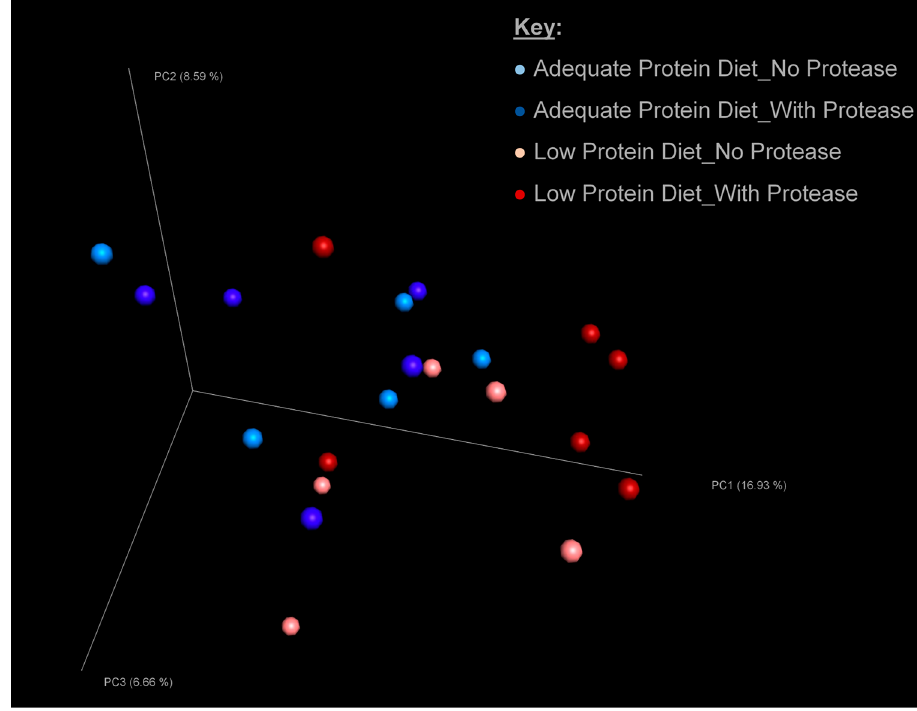
Figure 1. Principal coordinate analysis of β -diversity among sample groups. Bonferroni-corrected differences between treatments were not significant ( p = 0.99).